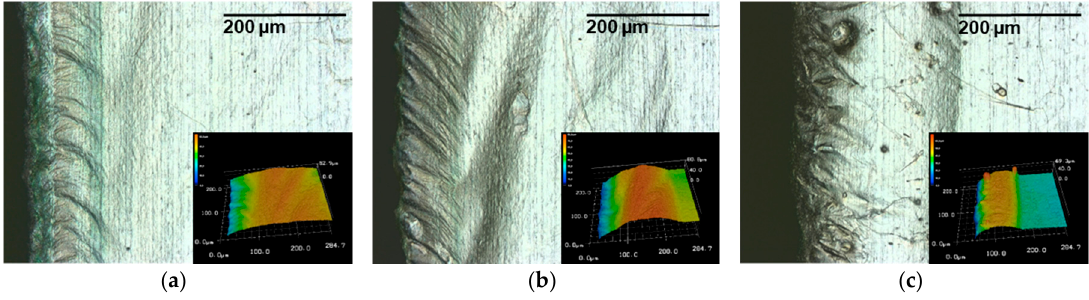
Figure 14. Light and laser scanning microscope sections of a laser cut lithium sheet: 72.8 W, 490 kHz, 240 ns, dew point − 30 °C; ( a ) 50 mm/s, PO 99.89%; ( b ) 100 mm/s, PO 99.77%; ( c ) 150 mm/s, PO 99.66%.